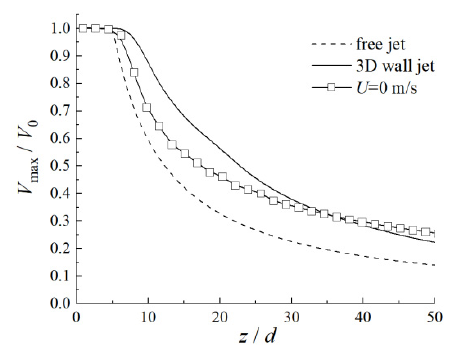
Figure 13. V max / V 0 attenuation of the horizontal discharge jet without considering the ambient wind.